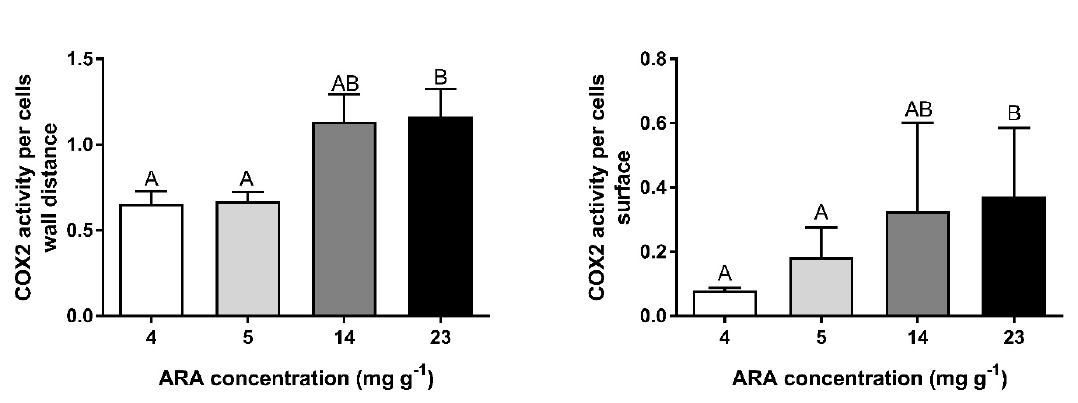
Figure 6. COX2-positive cells in the germinal epithelium and follicular layers in ovary of medaka females fed experimental diets containing 4, 5, 14, 23 mg ARA g − 1 of TFA. Data are expressed as means ± standard deviation (SD) ( n = 15). A,B Di ff erent letters above the bars indicate significant di ff erences ( p < 0.05) between groups.